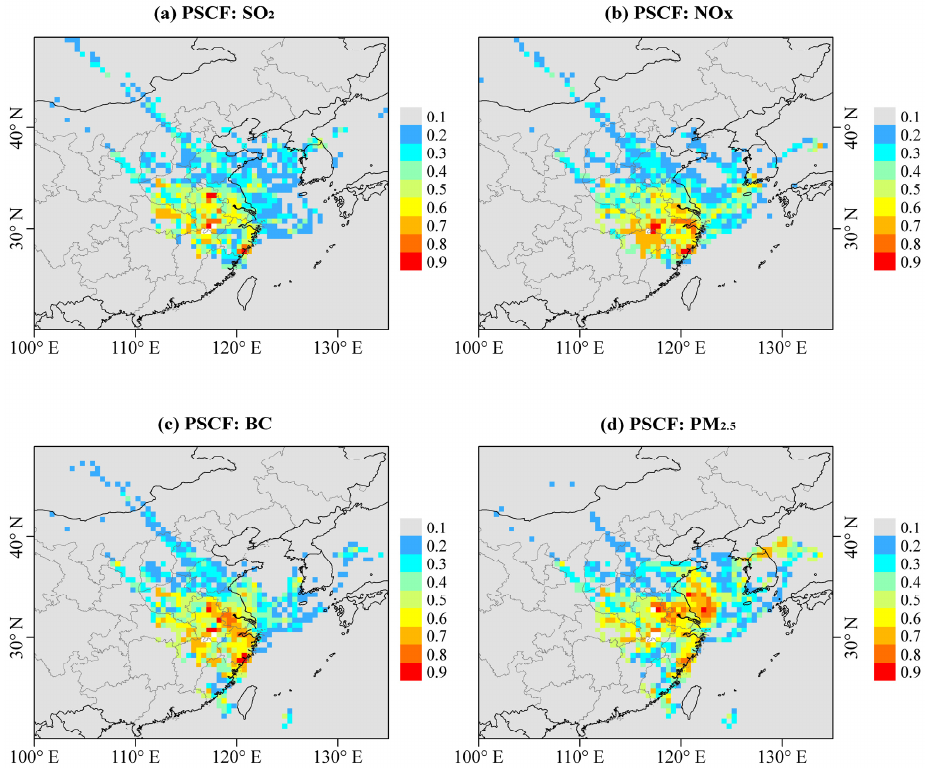
Fig. 3. Potential source contribution function (PSCF) maps for (a) SO 2 , (b) NO 2 , (c) BC, and (d) PM 2 . 5 Fig. 3. Potential Source Contribution Function (PSCF) maps for (a) SO 2 , (b) NO 2 , (c) BC, and (d) PM 2.5 .